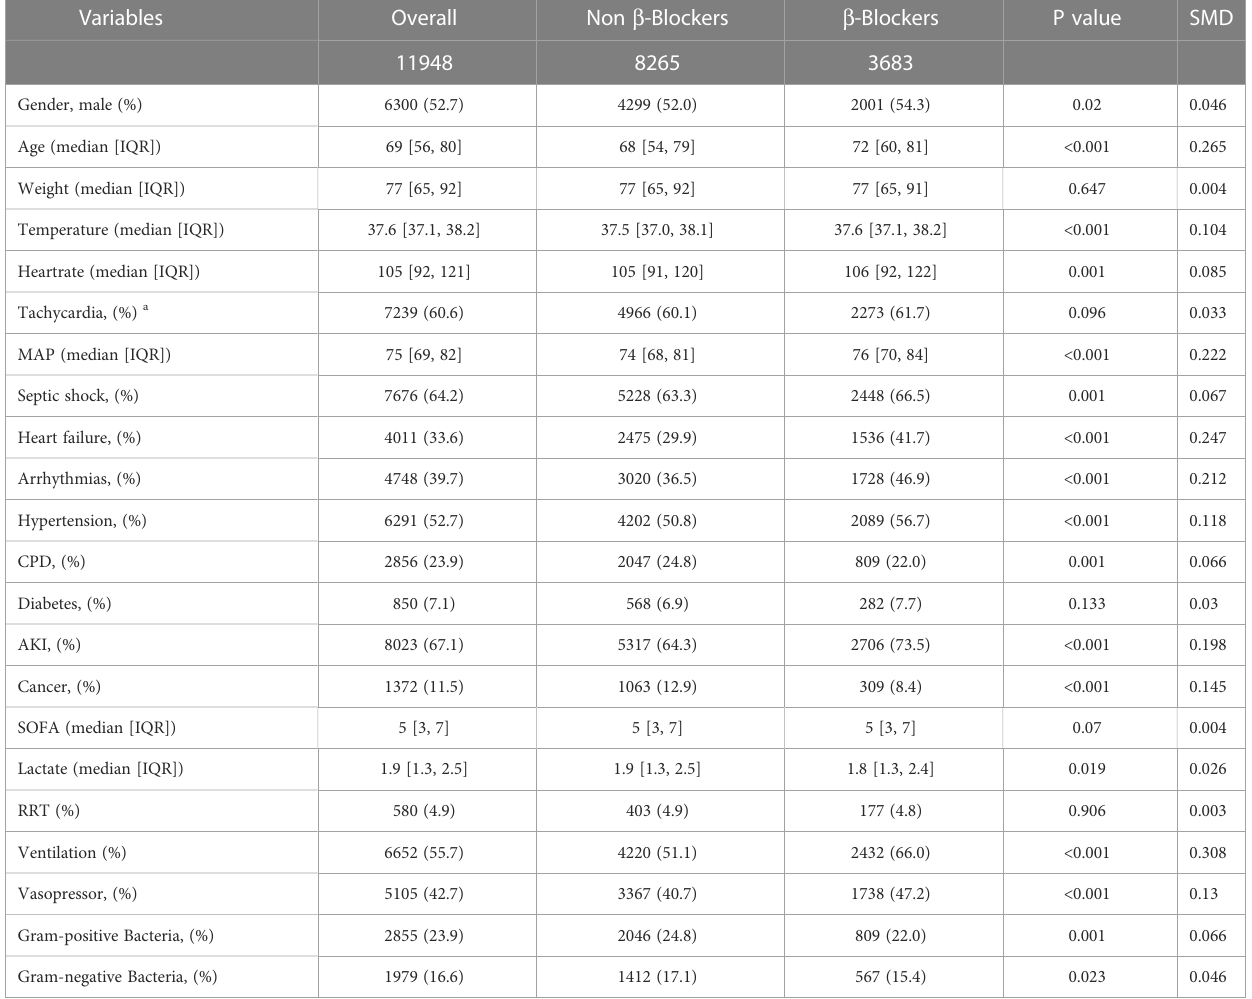
TABLE 1 Baseline characteristics of patients on admission before propensity score